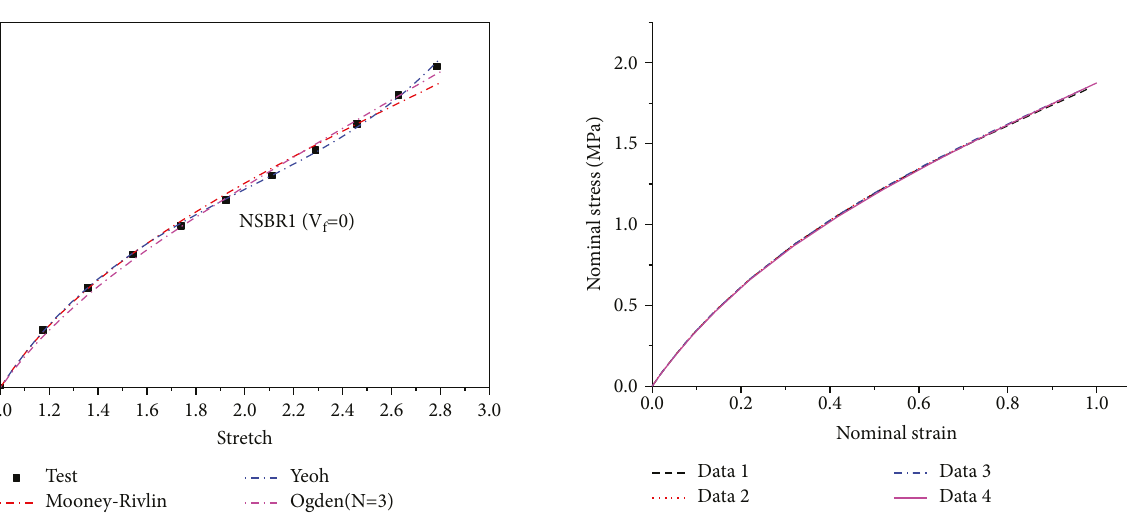
Figure 8: Stress-strain curves of di ff erent stochastic models with same particle size for NSBR6 in case of uniaxial tensile.